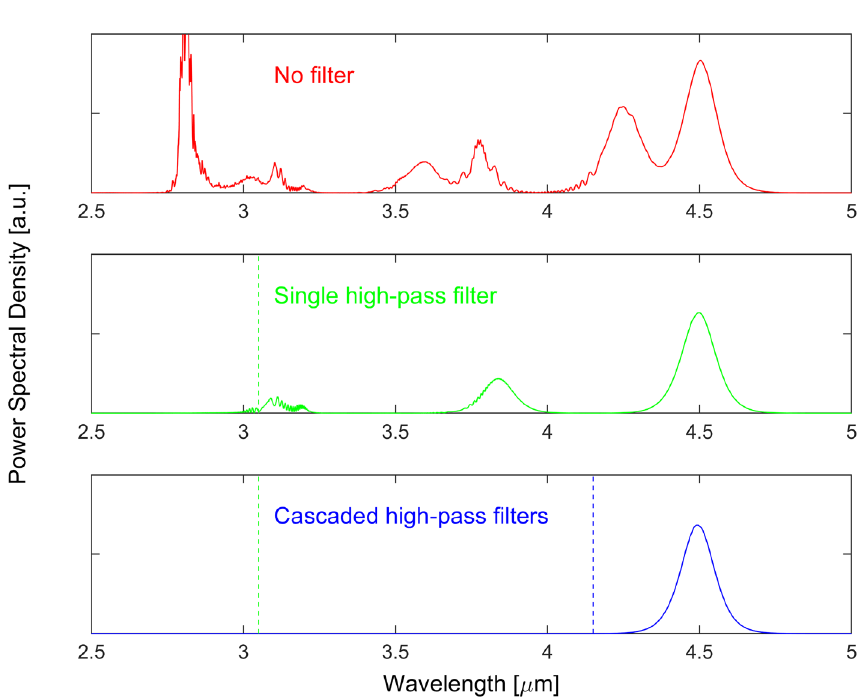
Figure 13. The impact of spectral filtering on the output signal: no filter (top), a single high-pass filter ( (cid:31) > 3.05 µm, green dash line) between the Er: ZrF 4 and the InF 3 fibers (middle), a cascade of two filters, the first high-pass filter between the Er: ZrF 4 and the InF 3 fibers followed by a second high-pass filter ( (cid:31) > 4.15 µm, blue dash line) at the output